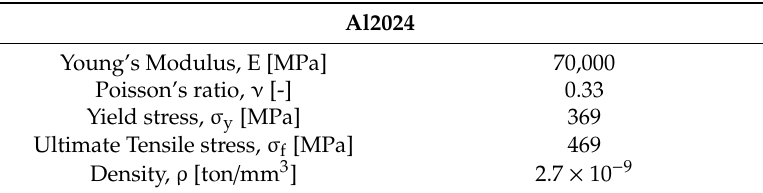
Table 4. Aluminum Al2024 mechanical properties.